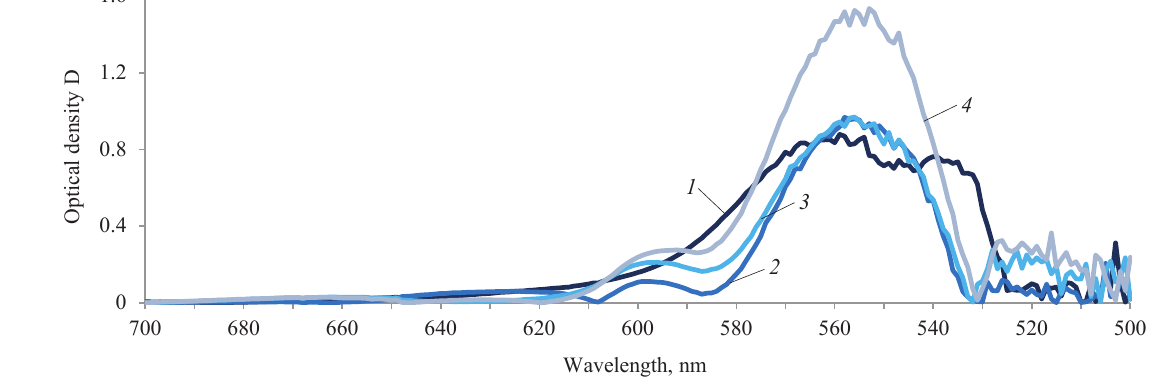
Figure 2 Optical density of paste samples with different concentrations of dry lingonberry marc extract